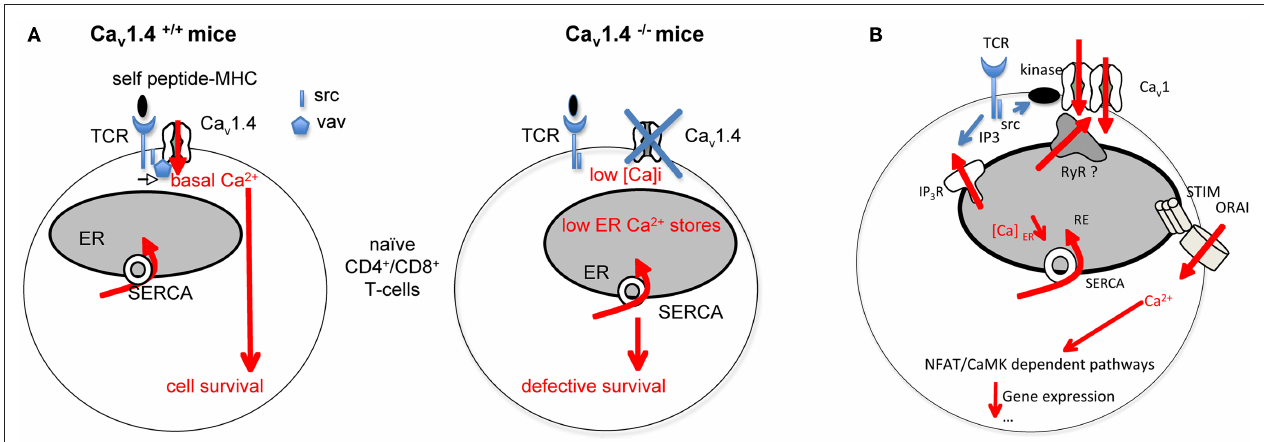
Figure 1 | role of Ca 1 channels in T-cell Ca 2 + responses and functions. (A) regulation in Th2-cells. TCR activation would lead to src and PKC enzyme v Ca activation. Possible PKC-Ca 1.4 is found localized in preformed complexes containing src kinase and Vav. 1.2 interactions would induce Ca v v Self peptide-MHC interactions with the TCR, independently of the antigen opening. specificity would induce a survival signal in naïve T-cells. This signal requires some calcium entry depending upon the Ca 1.4 containing complex. Ca 1.4 v v would be also important for maintaining correct endoplasmic reticulum (ER) Ca 2 + stores. Ca 1.4 null T-cells exhibit defective calcium homeostasis associated with v defective survival. (B) The scheme depicts how we assume Ca 1.2 channel v